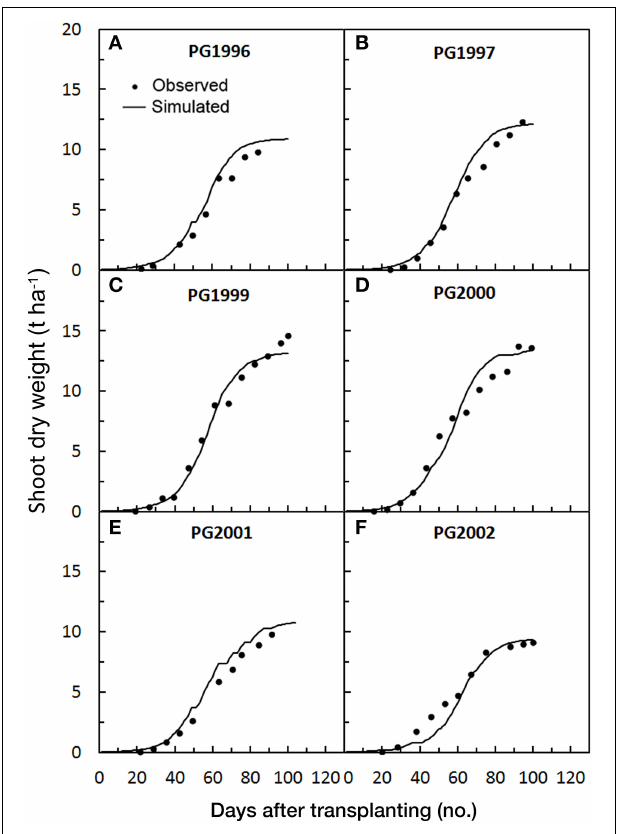
FIGURE 5 | Simulated and observed SDW accumulation during the six tomato cycles in Perugia [PG1996 (A), PG1997 (B), PG1999 (C), PG2000 (D), PG2001 (E), PG2002 (F)], used for validating GesCoN . Mean standard errors, when larger than the symbol, are represented by vertical bars.